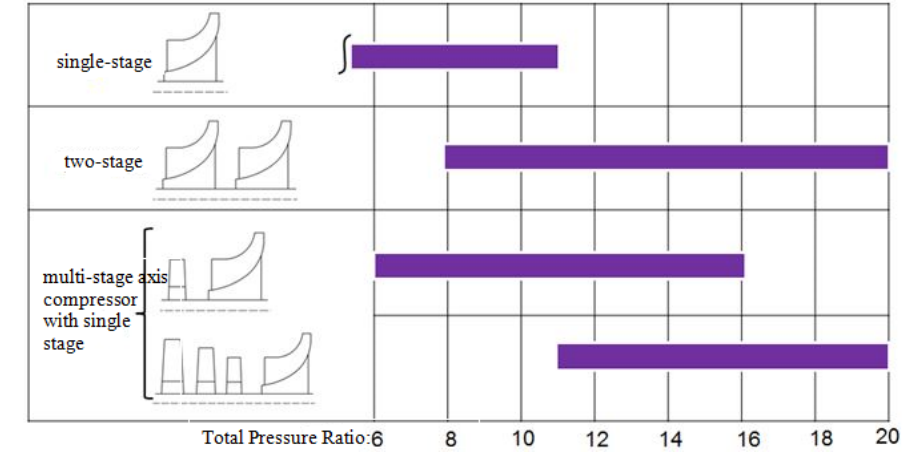
Figure 2. Comparison of centrifugal compressor pressure ratios.